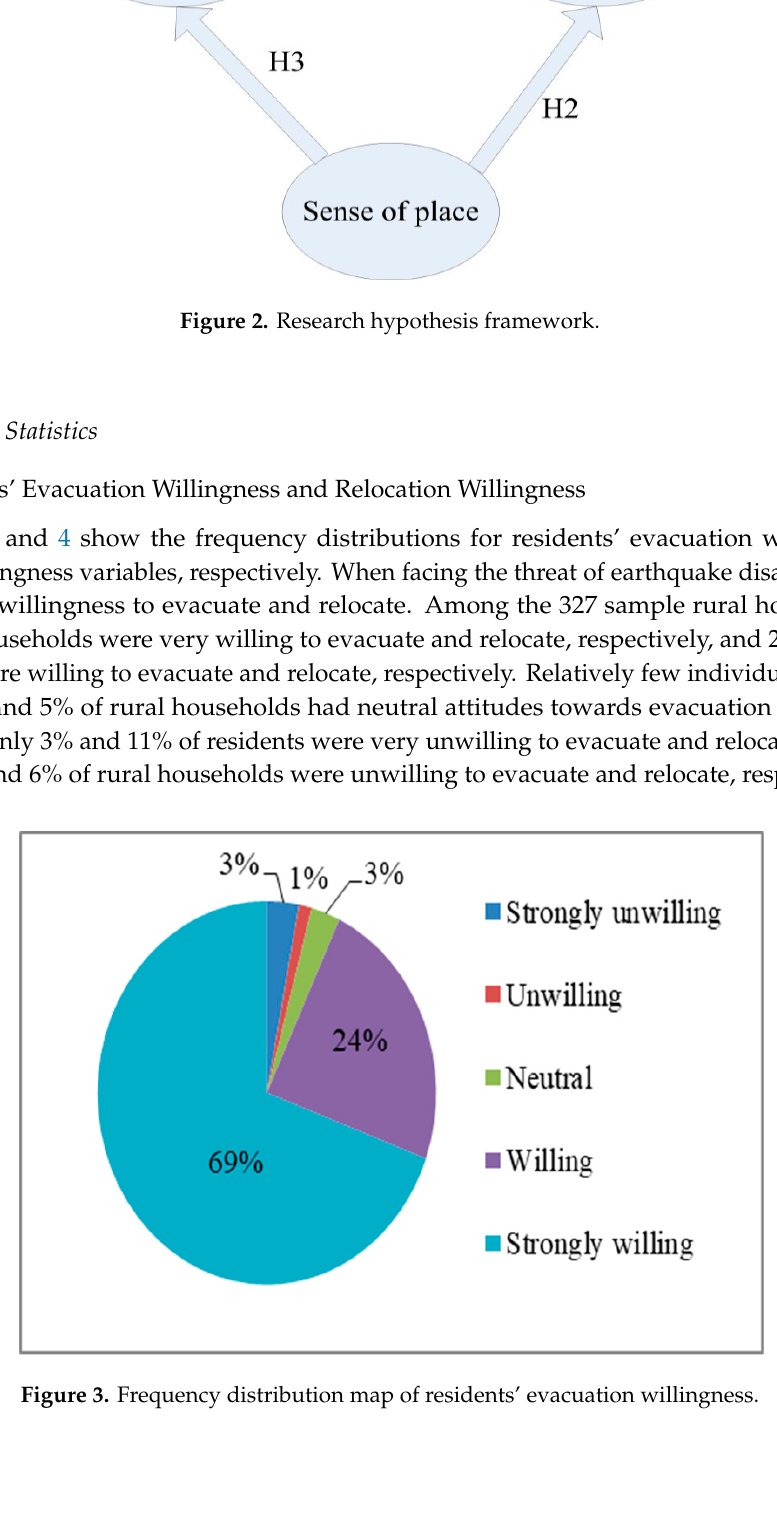
Figure 4. Frequency distribution map of residents’ relocation willingness. 3.1.2. Residents’ Disaster Risk Perceptions and Sense of Place As shown in Table 4, the average scores for all dimensions of residents’ disaster risk perception and sense of place were above 60, indicating a relatively balanced and stable state. Further, the difference in the degree of dispersion was very small, and the standard deviations fluctuated between 6 and 9. 3.1.3. Residents’ Individual and Family Socio-Economic Characteristics As shown in Table 4, 46% of the respondents were women. The average age of the respondents was 53.44 years, while the average years of education were 6.29 years. Residents’ average time in their residence was 41.71 years. In total, 82% and 57% of the respondents were Han people and farmers, respectively. Moreover, 89% of rural households believed that the experience of major earthquake disasters is very serious. With regard to residents’ family socio-economic characteristics, the average annual family cash income was 66,238.94 Yuan. In total, 48% and 24% of families contained elderly people and children, respectively, while 48% of rural households had concrete houses. Furthermore, 44%, 16%, and 40% of rural households’ information primarily came from the government, relatives and friends, and the media, respectively. 3.2. Model Results Table 5 shows the correlation coefficient matrix of the model variables. All correlation coefficients between variables were less than 0.80, indicating no serious multicollinearity between the independent variables of the models. Table 6 shows the regression results for residents’ disaster risk perception, sense of place, and evacuation willingness. Model 1 includes only the three